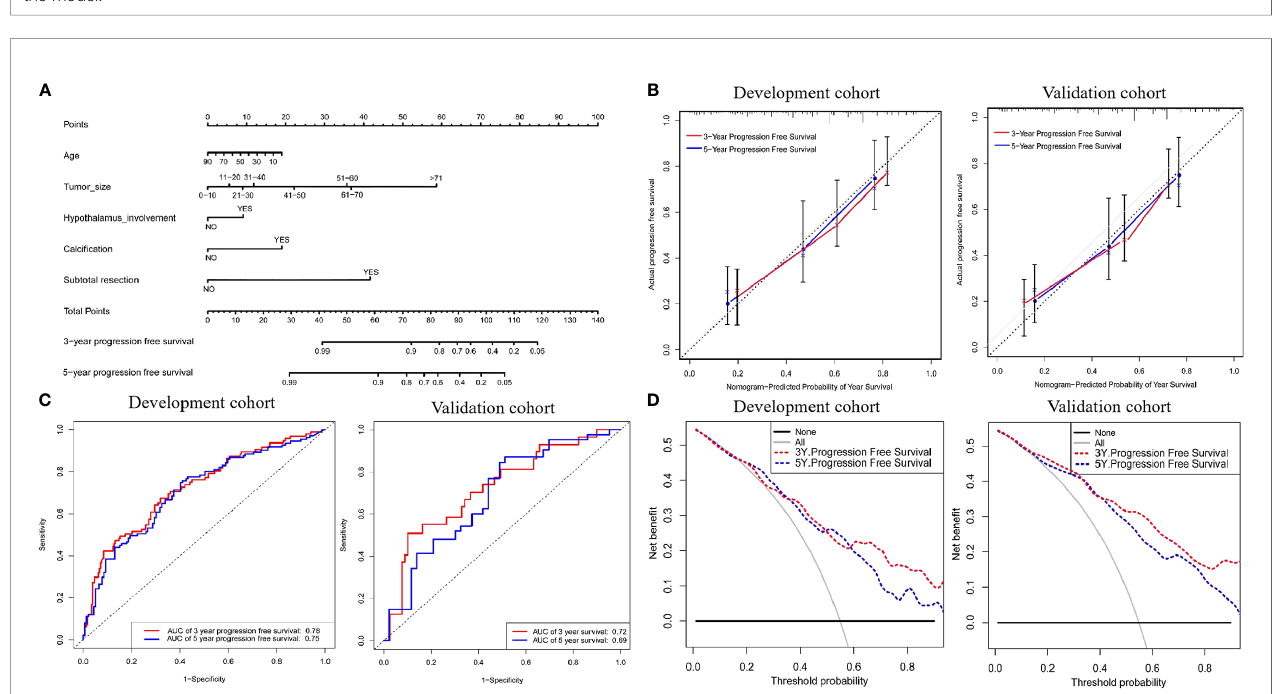
FIGURE 6 | (A) Nomogram for predicting the probability of 3- and 5-year progression free survival. For each variable, a verticle line was drawn to the upward point line and the total score of 6 variables could be obtained to calculate the probability of progression free survival. (B) Calibration curves for development and validation cohort. (C) The ROC curves of the nomogram, age, tumor size, hypothalamus involvement, calci fi cation, character and combined nomogram in the development and validation cohort. (D) The decision curve analysis of the nomogram. The Y-axis represents the net bene fi t. The larger net bene fi t means a patient can obtain the more bene fi t of the